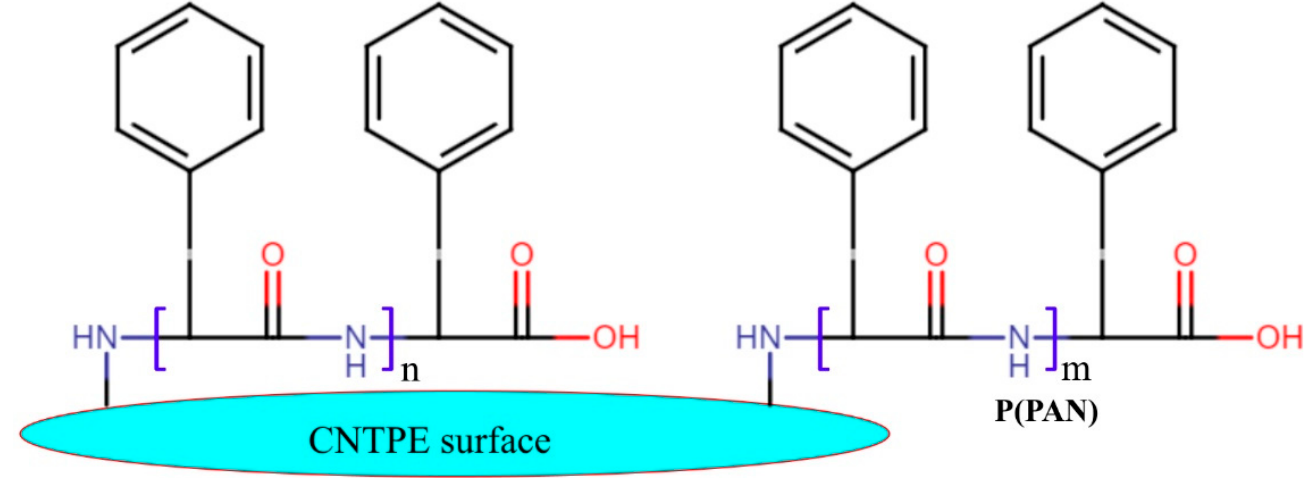
Figure 4. ( a ) Plot of I pa vs. number of cycles. ( b ) Cyclic voltammograms for the electro polymerization of PAN (1.0 mm) in PB (0.2 M & 7.0 pH) at the surface of CNTPE having the scan rate of 0.1 Vs − 1 .